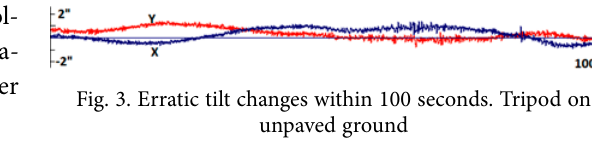
Fig. 3. Erratic tilt changes within 100 seconds. Tripod on